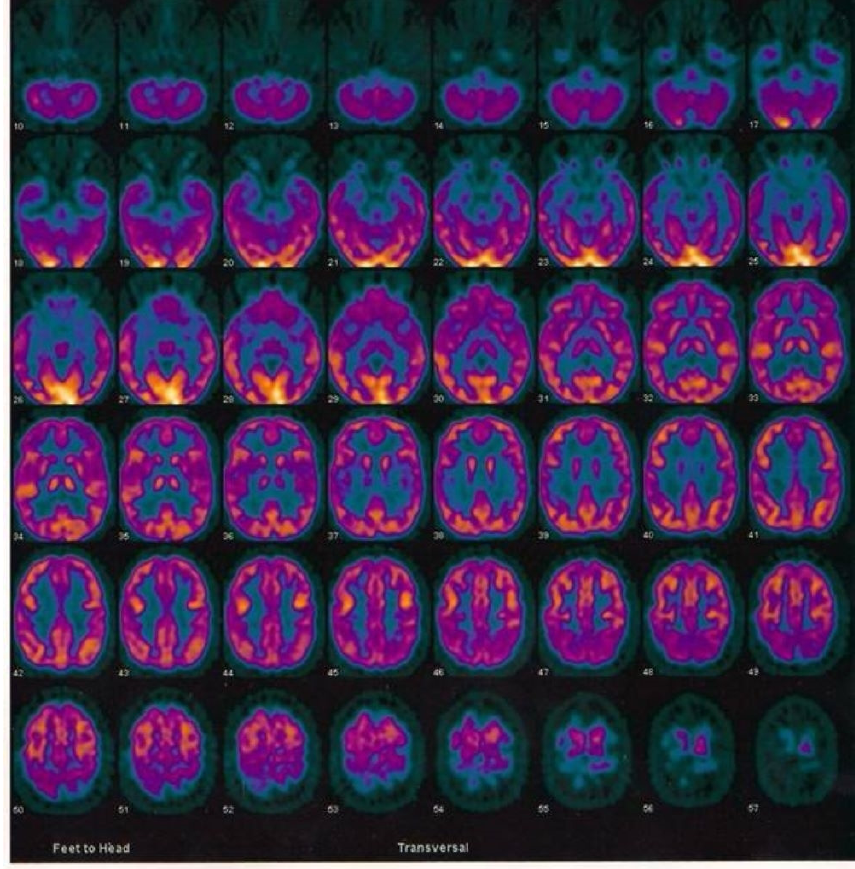
Figure 3. Results of fluorodeoxyglucose (FDG)- PET of the 76-year-old woman in the CuAD subgroup who was the carrier of the RGS7 stop-loss mutation. Note the marked bilateral hypometabolism of different regions in the frontal and temporoparietal cortex.